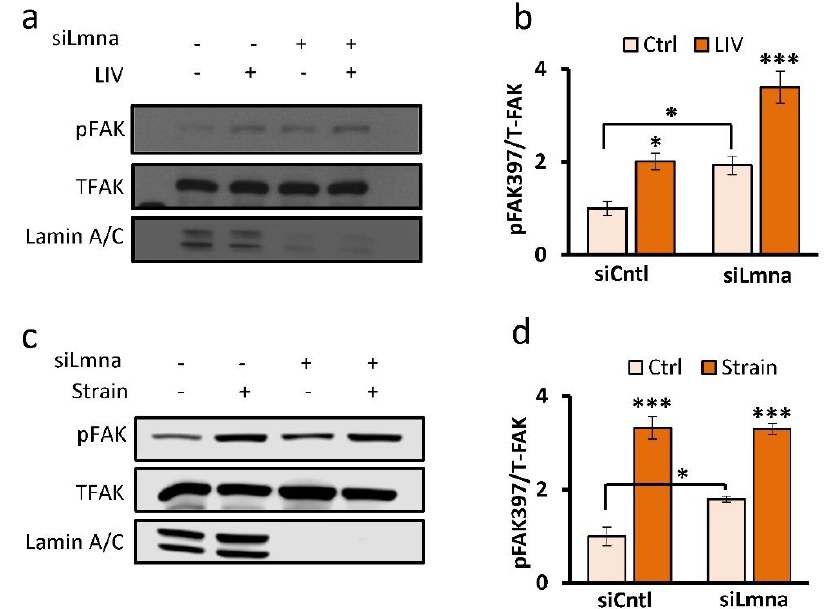
Figure 3. Focal adhesions maintain response to mechanical stimulus in lamin A/C depleted MSCs: ( a ) Representative western blots for pFAK (Tyr 397), TFAK, and lamin A/C in siCntl and siLmna treated cells groups treated with 2 bouts of LIV (20 min, 90 Hz, 0.7 g) separated by 2 hour rest period. LIV treated samples had a 2-fold increase of pFAK compared to non-LIV. ( b ) Analysis of western image of pFAK, TFAK, and lamin A/C during LIV ( n = 4/grp). The non-LIV siLlmna group had a 92% ( p < 0.05) increased basal pFAK compared to the non-LIV siCntl group. In response to LIV, both siCtnl and siLmna treated MSCs elicited 101% ( p < 0.05) and 87% ( p < 0.001) increases in pFAK, respectively, compared to non-LIV controls. ( c ) Representative western blots for pFAK (Tyr 397), TFAK, and Lamin A/C of the siCntl and siLmna groups treated with a single bout strain (20 min, 0.1 Hz, 2% strain). ( d ) Analysis of pFAK, TFAK, and lamin A/C immediately after strain application ( n = 4/grp). The non-strain siLmna group had a 79% ( p < 0.05) increased basal pFAK compared to the non-strain siCntl group. In response to strain, pFAK levels were elevated by 331% ( p < 0.001) and 83% ( p < 0.001) in siCtnl and siLmna treated MSCs respectively. Results are presented as mean ± STE. Group comparisons were made via one-way ANOVA followed by a Newman-Keuls post-hoc test. * p < 0.05, *** p < 0.001, against control or against each other.